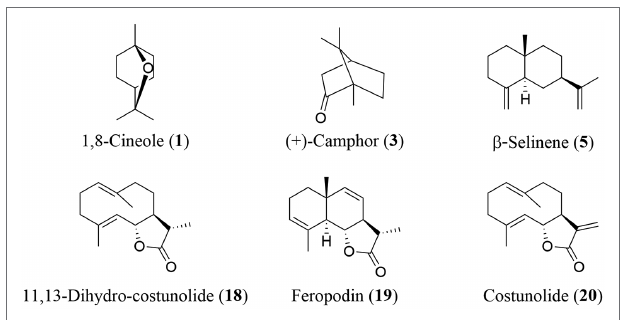
FIGURE 2 | Chemical structures of terpenes in the essential oils extracted from A.